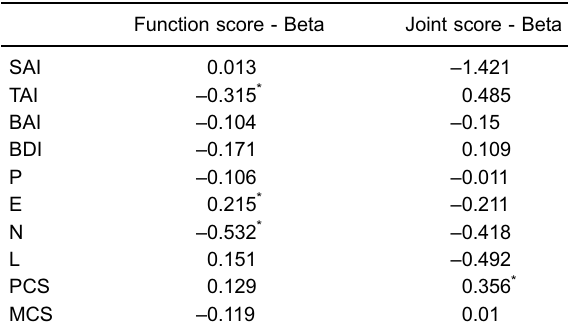
Table 4. Multiple linear regression analysis of the Knee Society Score at 6 months after surgery and related scale